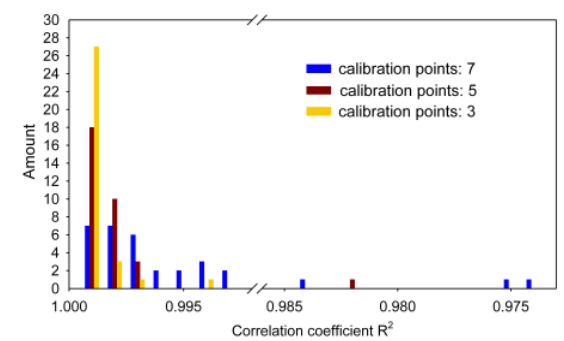
Figure 5: SD distribution for empirical calibrations with 3, 5 and 7 calibration points at constant inter-point separations of 90 min arc.